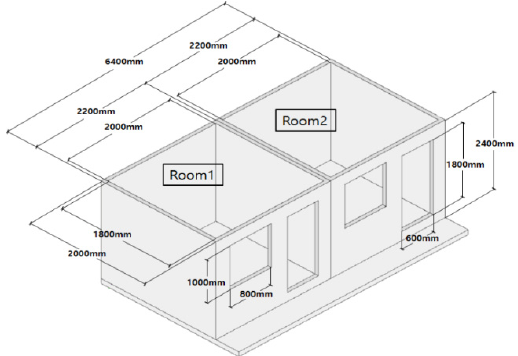
Figure 6. 3D visualization of the mock-up rooms. Table 2. Characteristics of the model rooms used to test the proposed floor heating system.